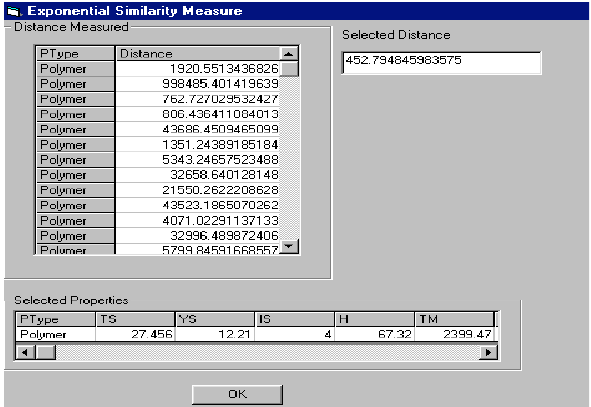
Fig. 6(d): Materials selected using Exponential Similarity Measure.